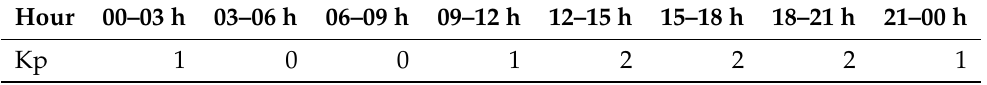
Table 6. Hourly Kp for the 5 March 2015.